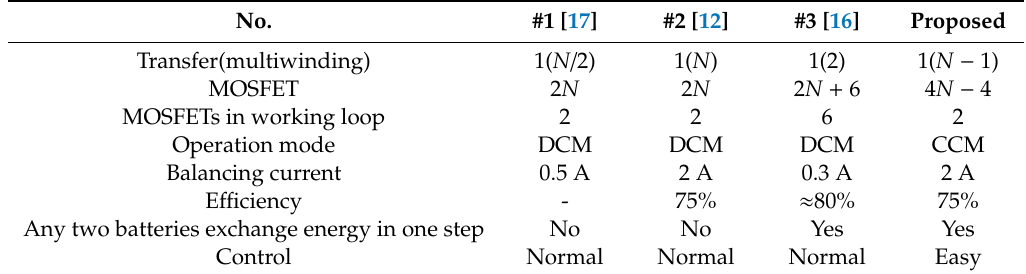
Table 4. Comparison of the di ff erent direct cell-to-cell equalization methods.